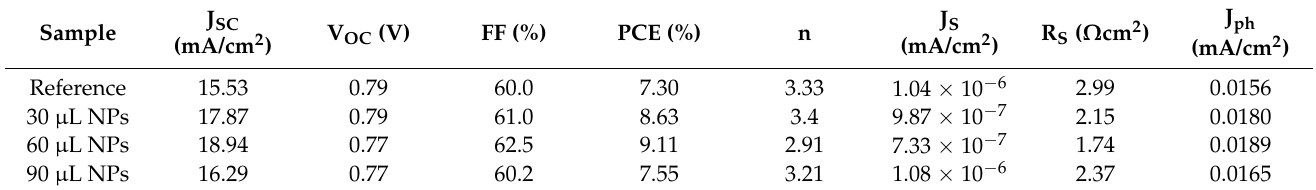
Table 2. Summary of the photovoltaic performance of the organic solar cells with different concentra- tions of the Au–Ag nanoparticles in the PEDOT: PSS: experimental and MATLAB